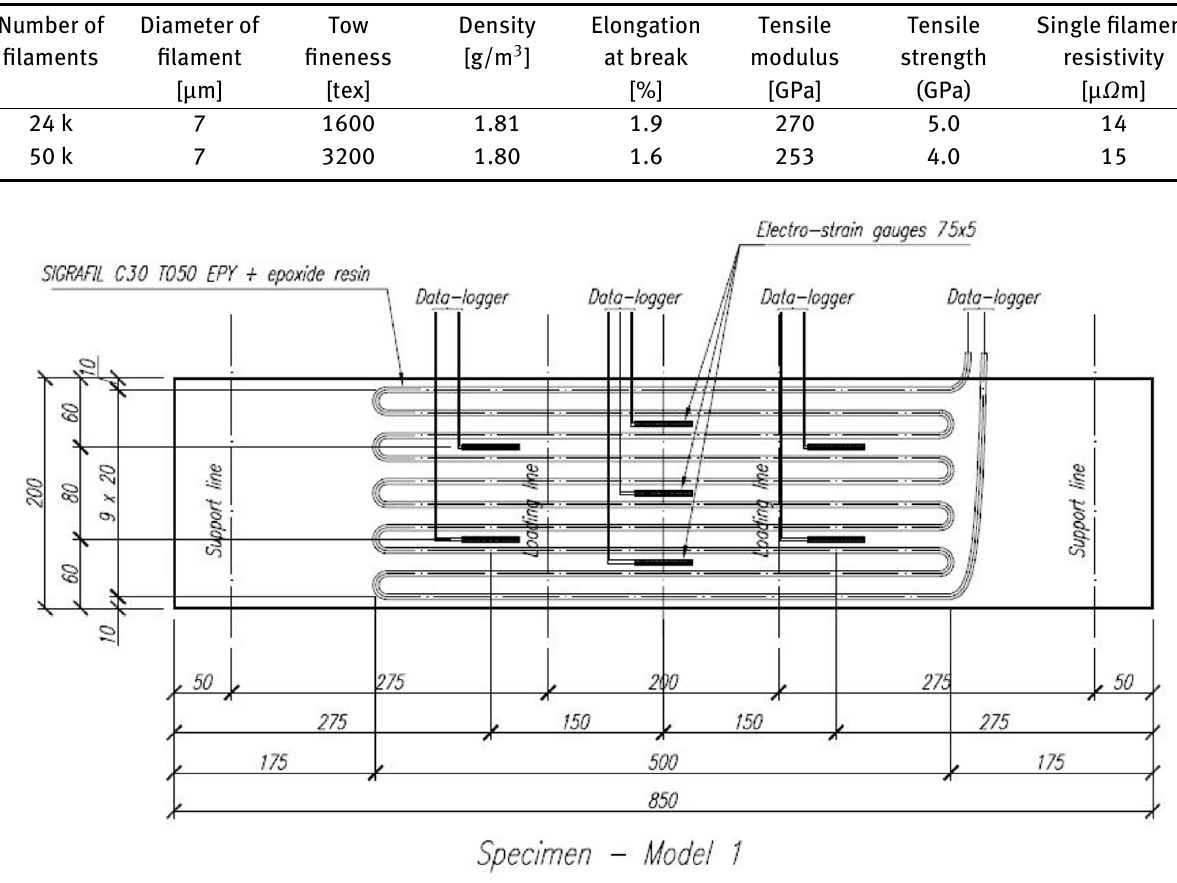
Table 1: Mechanical and electrical properties of carbon tow used in the research.